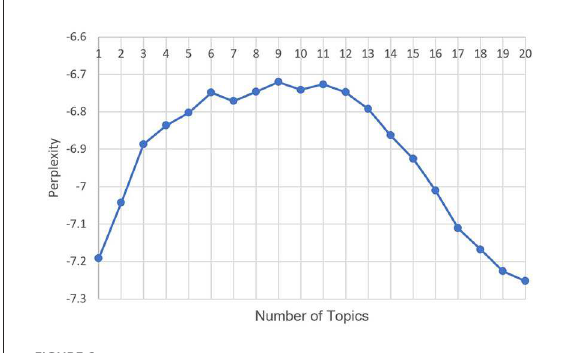
FIGURE6 Relationship between the number of topics and the perplexity in fear posts.